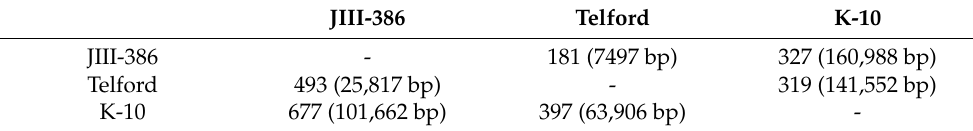
Table 3. Number of insertions and their total length in JIII-386, Telford, and